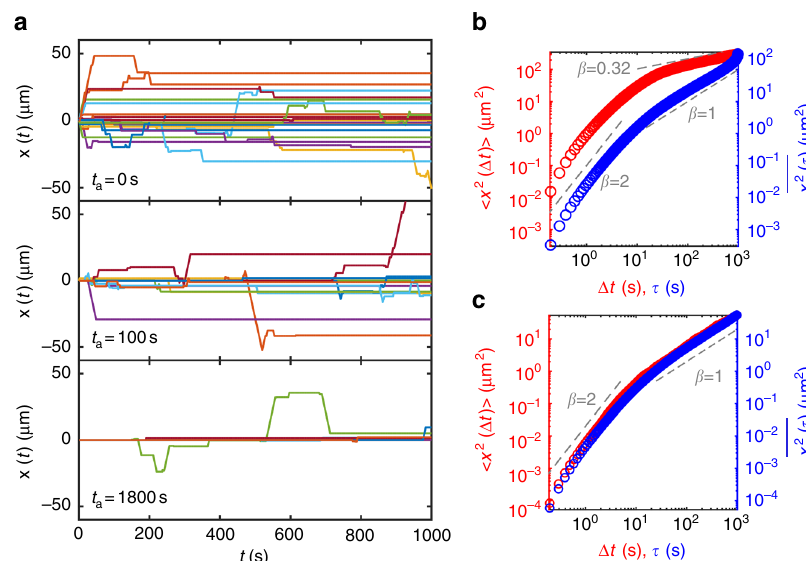
Fig. 3 Weak ergodicity breaking and aging in the simulation of truncated Lévy walk with rests. a Sample trajectories from the simulations with three different measurement initiation times t a (see Fig. 2a). Top: Lévy walk trajectories when the measurement begins with the start of the process ( t a = 0). Middle: Trajectories when the measurement is initiated at t a = 100 s. Bottom: Trajectories with the aging time t a = 1800 s. In each panel, 436 trajectories are plotted, the majority of which are silent trajectories. b EA and TA MSD curves when the measurement initiation time is the same as the process start time (i.e., t a = 0, top panel in ( a )). Inequivalence between the EA and TA MSDs, called weak ergodicity breaking, is clearly visible in this case. For times longer than the run characteristic time, the scaling for EA MSD approaches (cid:5) ð Δ t Þ α while the scaling for TA MSD follows ~ τ 1 . c EA and TA MSD curves when the measurement is initiated at t a = 1800 s after the start of the process (bottom panel in ( a )). Owing to aging, the EA MSD also shows the same apparent Fickian scaling as in the TA MSD for τ r < Δ t < T . Note that aging obscures weak ergodicity breaking in this